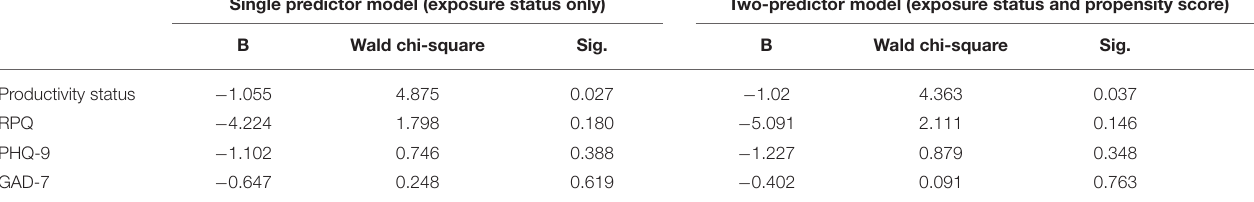
TABLE 3 | Generalized linear models. Single predictor model (exposure status